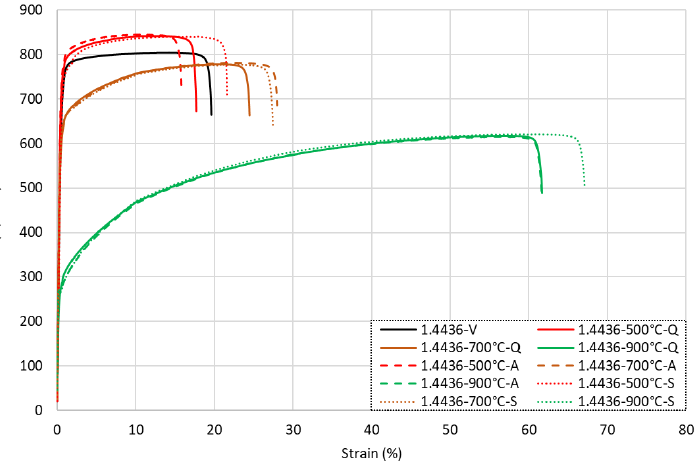
Figure 9. Stress – strain responses for grade 1.4436 stainless steel rebars following exposure to 500 °C, 700 °C, and 900 °C with various cooling.